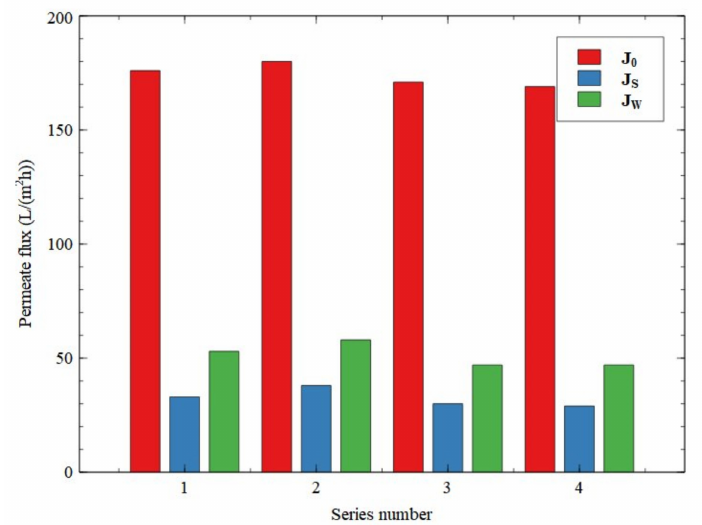
Figure 9. Changes in the performance of the UF membrane during the cyclically repeated operation: filtration-rinsing with 1% NaOH solution. J 0 —initial (maximum) permeate flux, J s —steady-state permeate flux, J w —permeate flux after membrane rinsing with water.